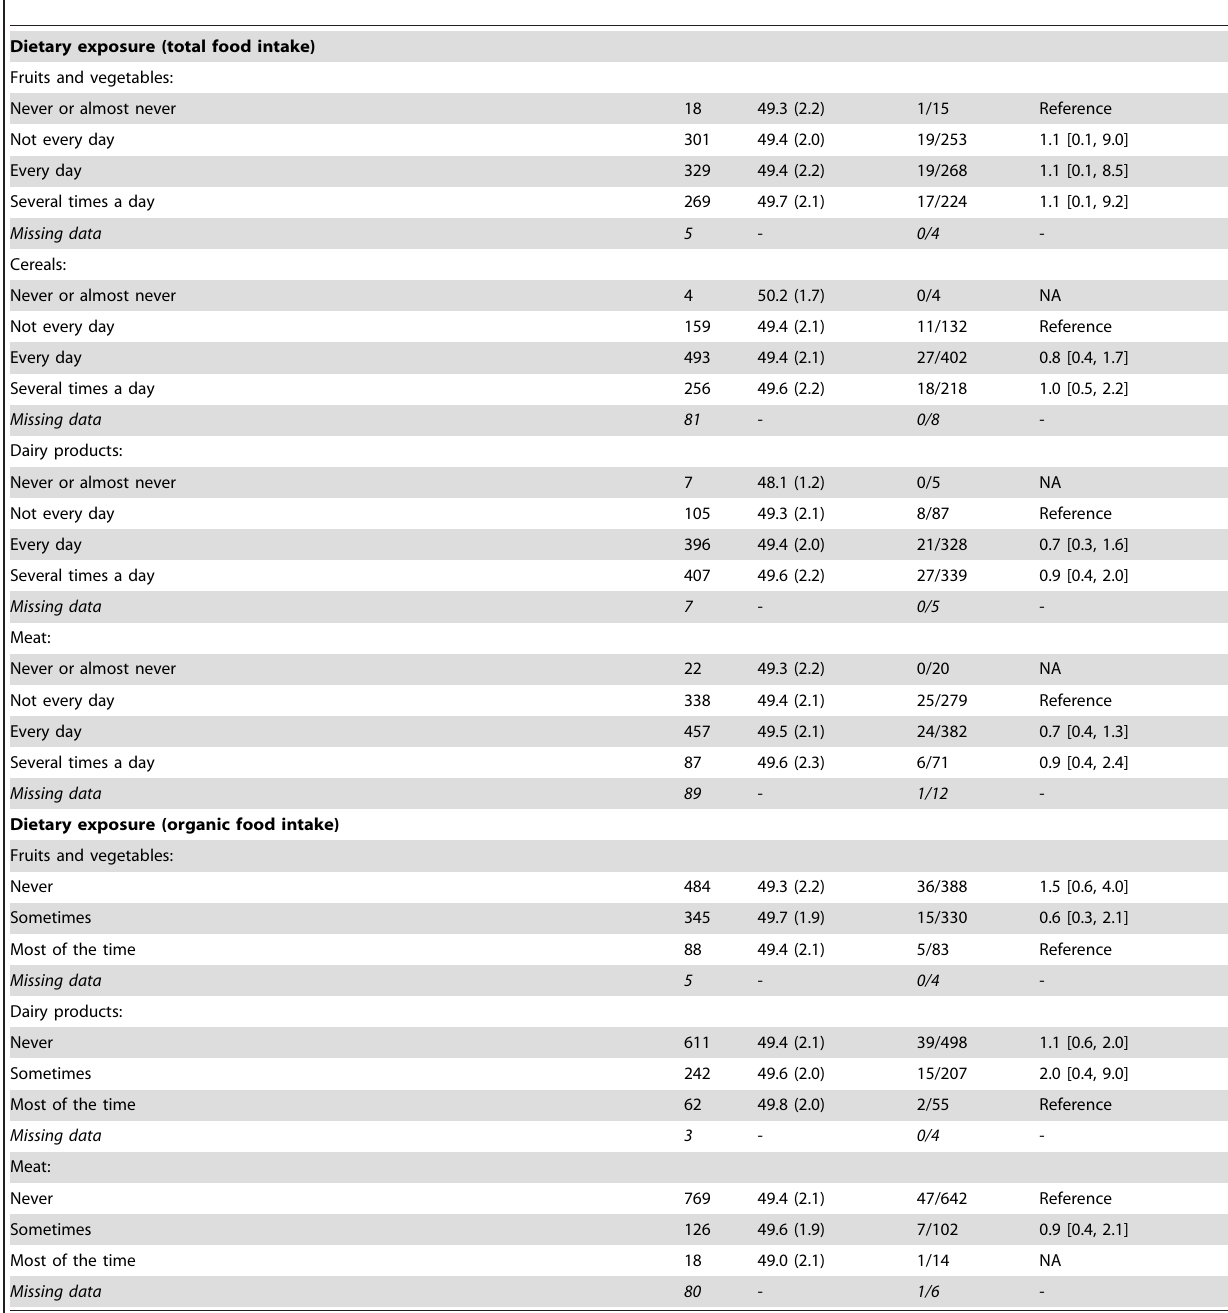
Table 10. Multivariate associations between (i) variables related to in utero exposure to pesticides, (ii) birth length (BL, in cm) and low birth length)